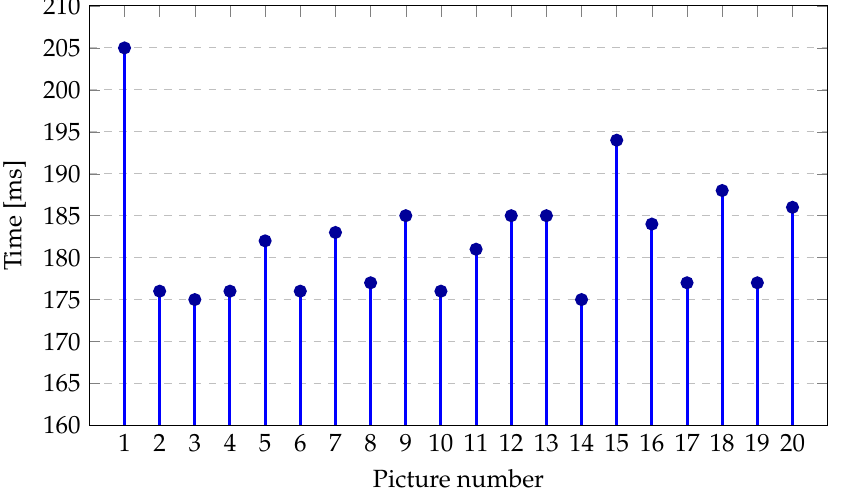
Figure 9. Time performance for the V. destructor